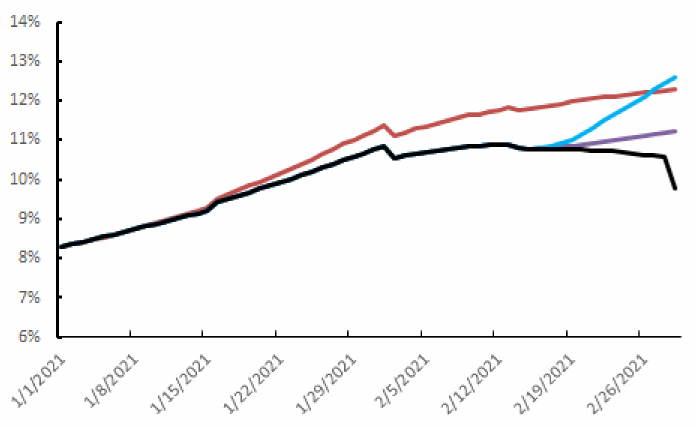
Figure 3. Daily spread of SARS-CoV-2 infection, 1 January 2021 to 1 March 2021 depending on the vaccine strategy and the release of public health measures or testing–tracing from 14 February 2021. Black curve: current situation, purple curve: reducing mass testing by half, blue curve: end of mass testing strategy, red curve: no vaccination